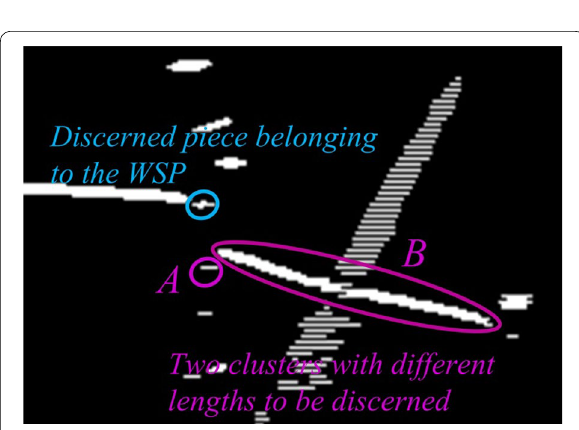
Figure 6 Example of the case in which clusters with bigger sizes should be discerned as part of the WSP than ones with smaller sizes when other factors cannot